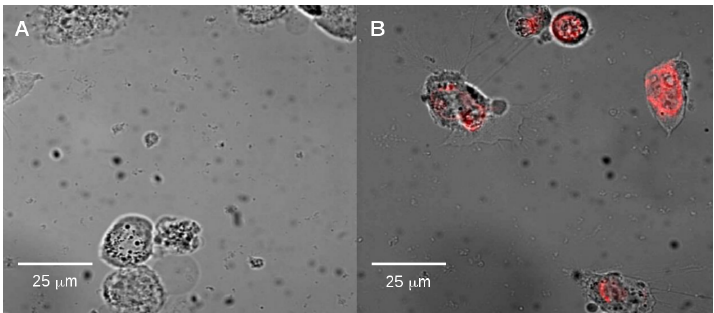
Figure 3. ( A ) CACO-2 cells treated for 4 h with blank vehicle (0.1% v / v diethyl ether) and ( B ) with vehicle + SiQDs (0.2 µ g mL − 1 ). The (orange–red) false color fluorescent image is superimposed on the bright field optical images indicating internalization of SiQDs in